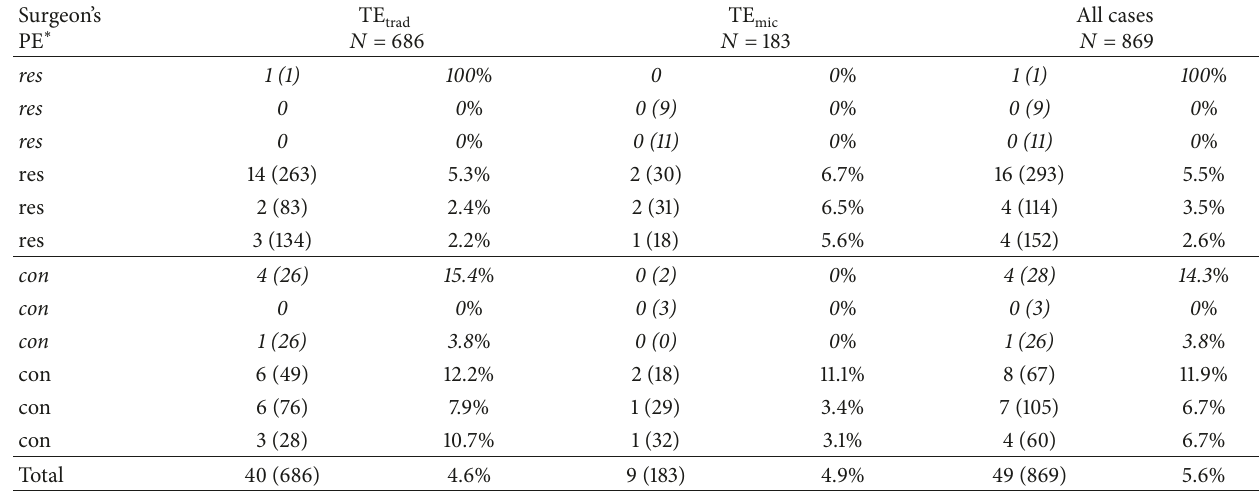
Table 4: Rates of posttonsillectomy hemorrhage (PTH), displayed by the professional experience of the surgeons.